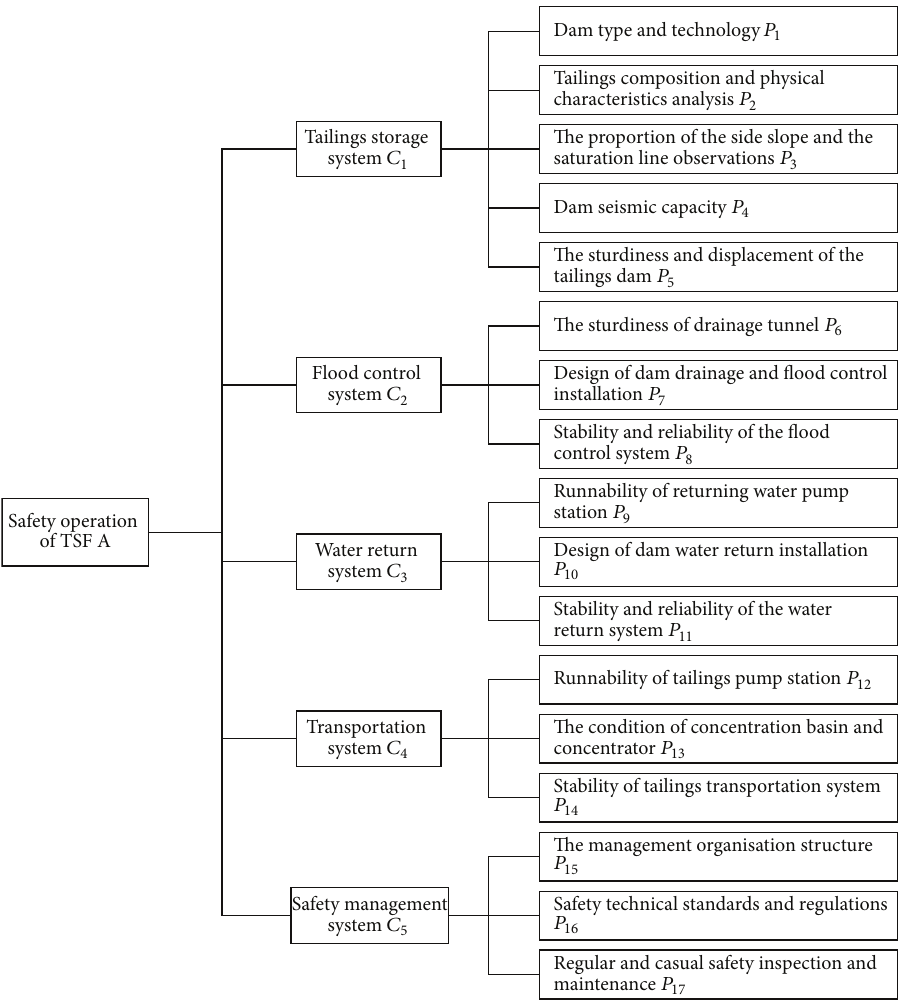
Figure 3: Evaluation structure for the safe operation of the